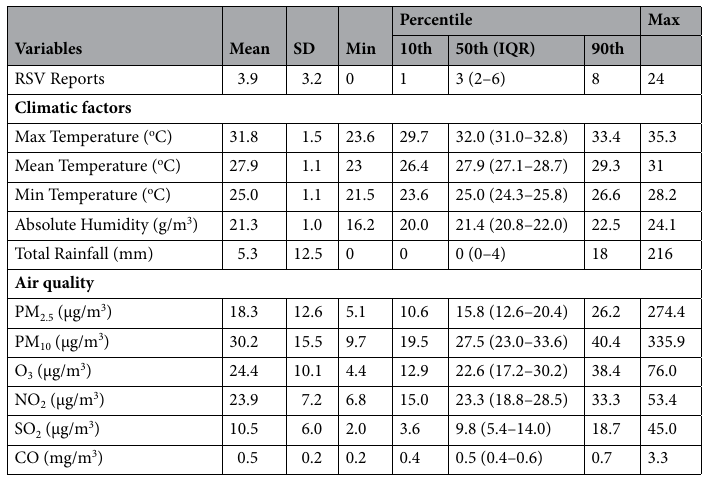
Table 1. Summary statistics of daily climatic factors, air pollution and RSV reports, 2009–2019. SD Standard